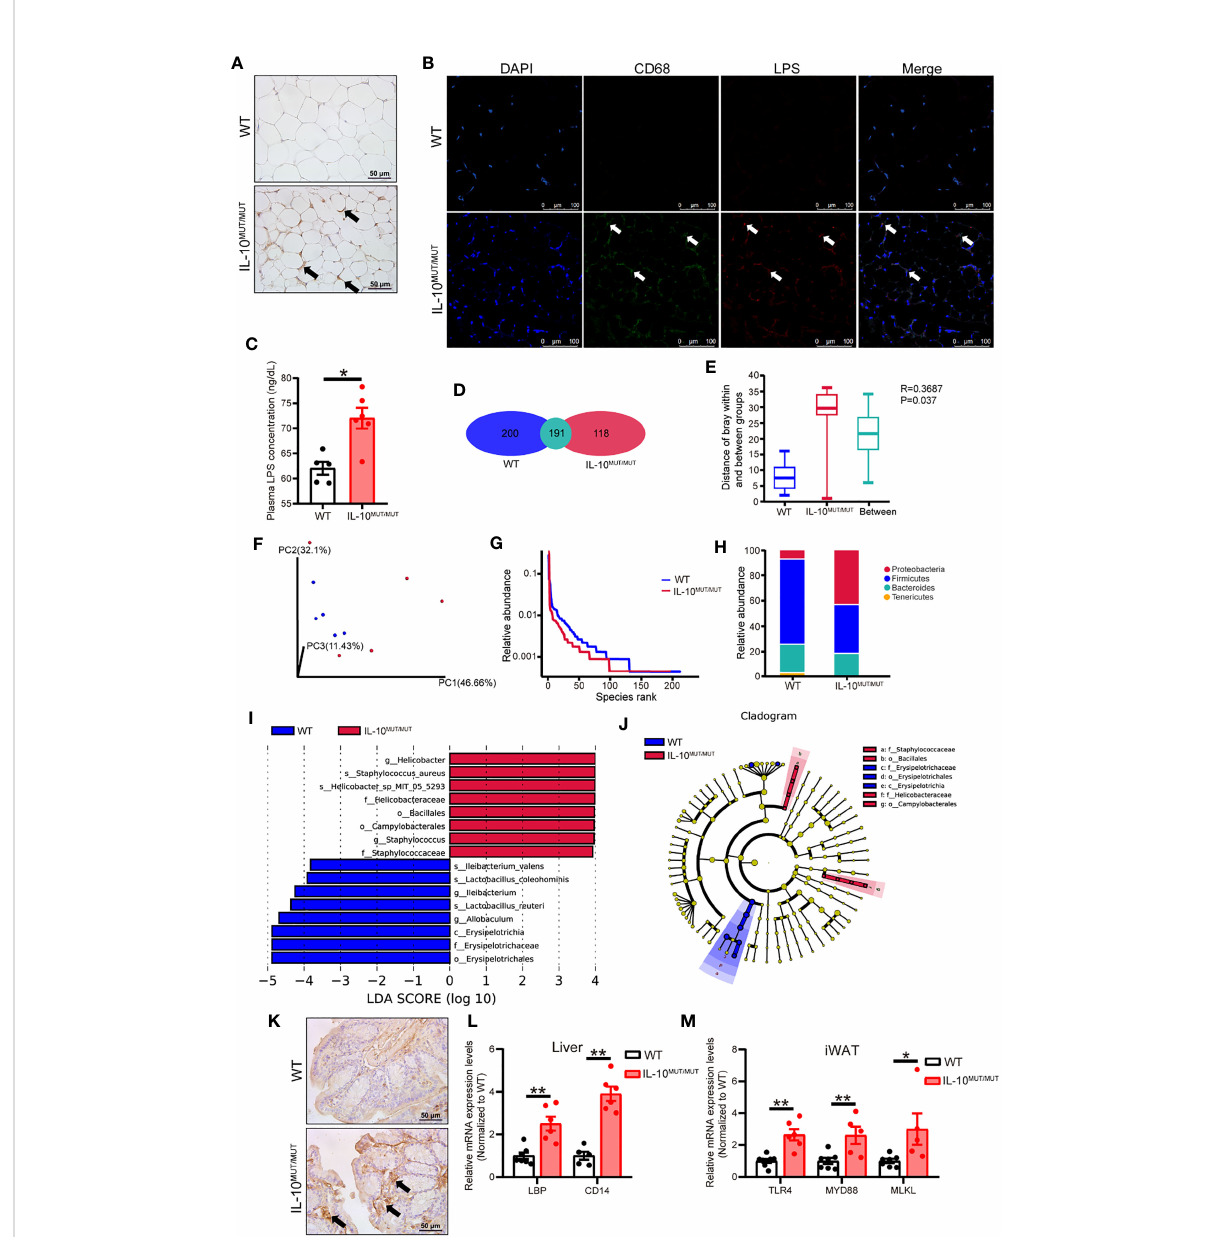
FIGURE 4 Loss of IL-10 disrupted the pro fi le and products of gut microbiota in IL-10 MUT/MUT hamsters on chow diet. (A) Immunohistochemistry of LPS in the iWAT from WT and IL-10 MUT/MUT hamsters. Bars: 50 m m; arrows indicate positive staining. (B) Cryo-sections of iWAT from WT (top) and IL- 10 MUT/MUT (bottom) hamsters were double-stained with CD68 (green) and LPS (red) antibodies. Nuclei were stained with DAPI (blue). Bars: 100 m m; white arrows indicate positive staining. (C) Plasma LPS levels were determined from WT and IL-10 MUT/MUT hamsters (n=5/group). (D) Analysis of the total number of OTUs present in WT hamsters (bule), IL-10 MUT/MUT hamsters (red) or overlap in both groups (Cyan). (E) Boxplots depicting differences in gut microbiota diversity in WT hamsters, IL-10 MUT/MUT hamsters and both the two groups. (F) Weighted Unifrac distance based analysis of PCoA. WT group was shown in blue, while the IL-10 MUT/MUT group was indicated in red. (G) Analysis of Rank abundance curves in WT and IL-10 MUT/MUT hamsters. The x-axis indicates the order number ranked by the OTUs abundance and Y-axis shows the relative abundance of OTUs. (H) The relative abundance of top 4 species at the levels of phylum in WT and IL-10 MUT/MUT hamsters. (I) LEfSe comparison of the gut microbiota between WT (bule) and IL-10 MUT/MUT (red) hamsters. LDA score>3 are shown. The length of the bar represents the LDA score. (J) LEfSe analysis of cladogram of signi fi cant changes at all taxonomic levels in WT and IL-10 MUT/MUT hamsters. The diameter of each circle is proportional to its abundance. (K) Immunohistochemistry of LPS in the colon from WT (left) and IL-10 MUT/MUT (right) hamsters. Bars: 50 m m; arrows indicate positive staining. (L) Expression levels of LBP and CD14 in liver were determined by real-time PCR (n=5/group). (M) Expression levels of TLR4, MYD88 and MLKL in iWAT were determined by real-time PCR (n=5/group). All date were expressed as means ± SEM, *p<0.05;